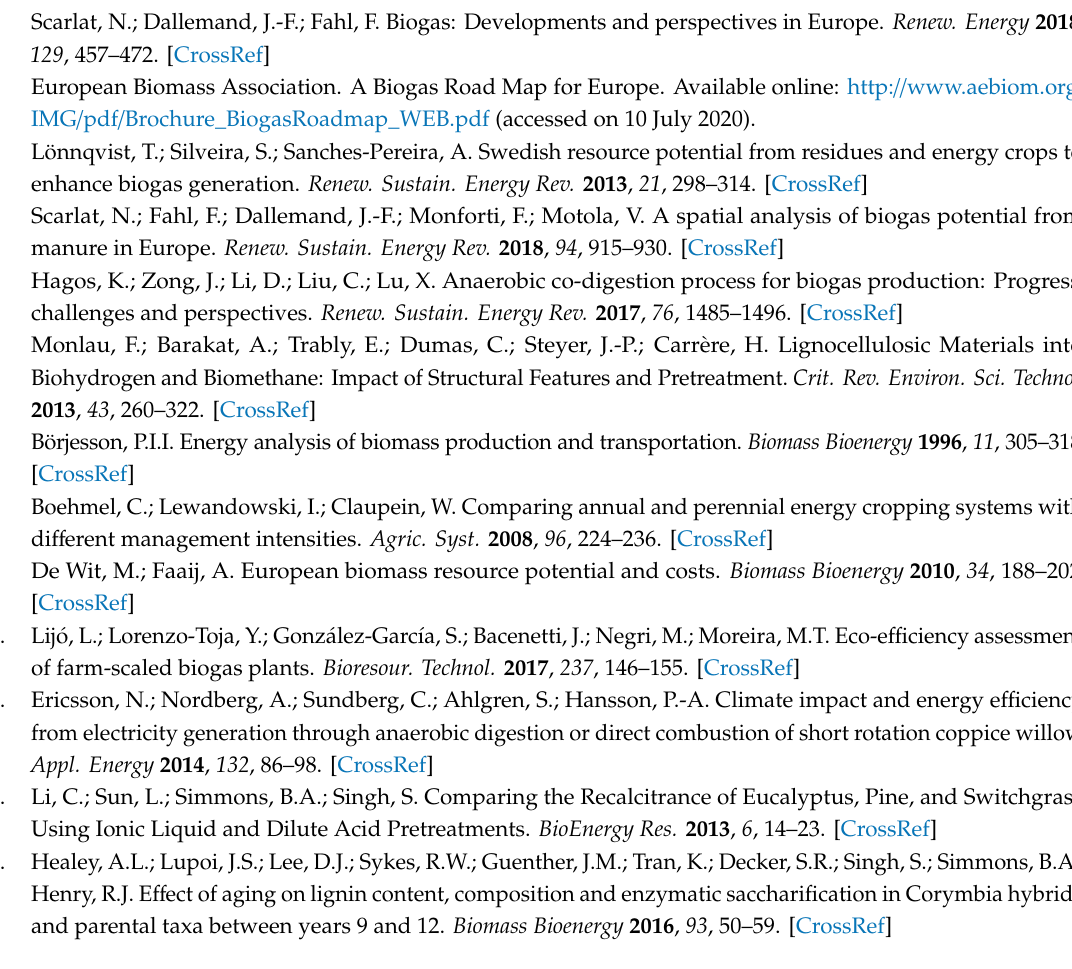
Table S1: ANOVA table for the comparison of biomass yields by clone and shoot age at harvest (Type III table with Satterthwaite’s method), Table S2: Estimated marginal means (EM means) of biomass yields by clone and shoot age. Yields are compared within shoot ages at the significance level of α = 0.05, with clones sharing the same letter (compact letter display, CLD) not being significantly di ff erent from each other, Table S3: ANOVA table for the comparison of biomethanation potential by clone and shoot age. Supplementary File S2: Harvest data for the field